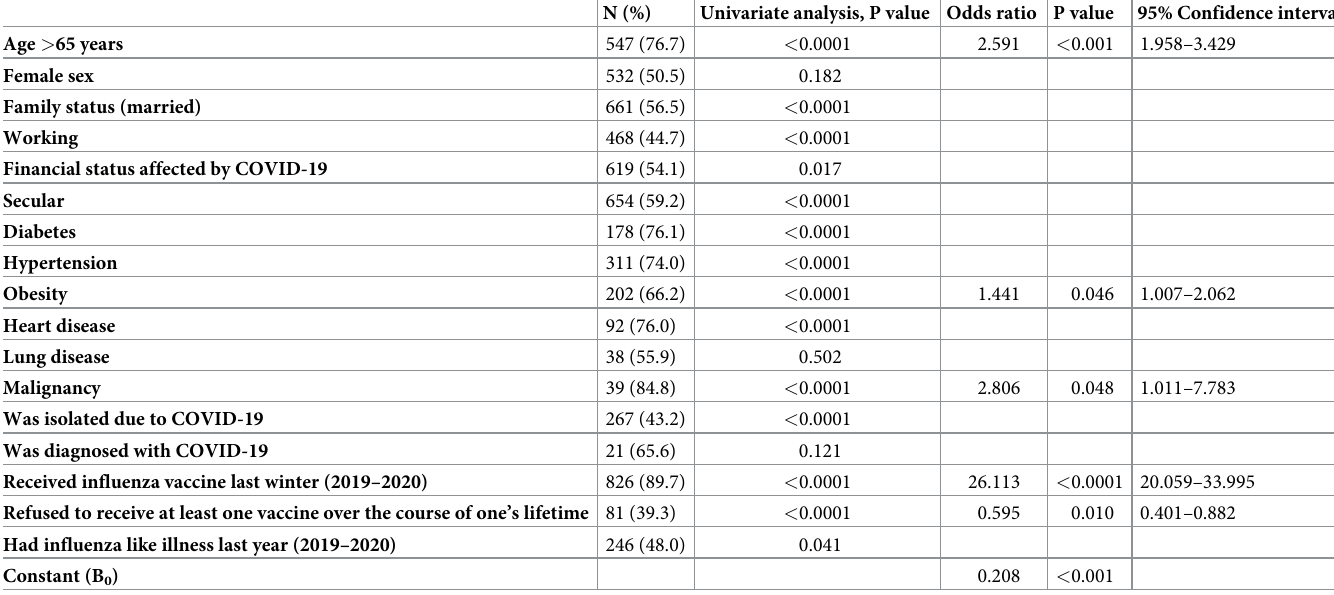
Table 3. Factors independently associated with plan to receive influenza vaccine this coming winter